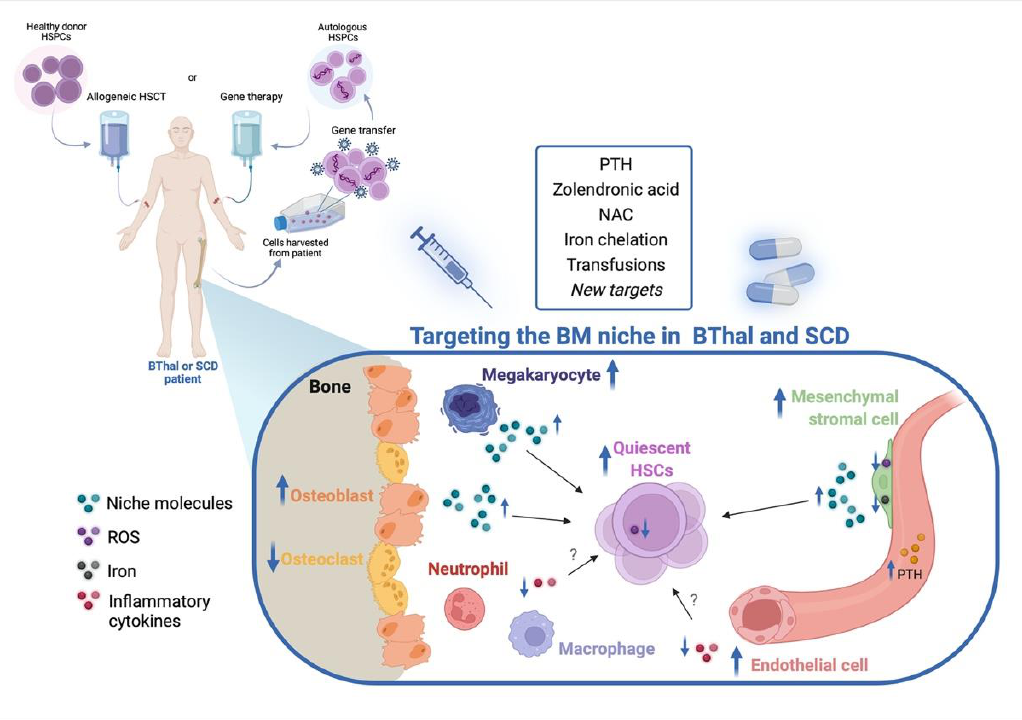
Figure 2. Targeting of the BM niche in BThal and SCD. Administration of treatments targeting the altered HSC niche components can be developed in combination with allogeneic or autologous gene therapy HSCT to restore the BM microenvironment. This may ameliorate the quality of patient- derived HSCs that are harvested and manipulated in gene therapy settings and, at the same time, make the BM niche more permissive for the engraftment of donor cells, both in the allogeneic and the autologous HSCT. Created with